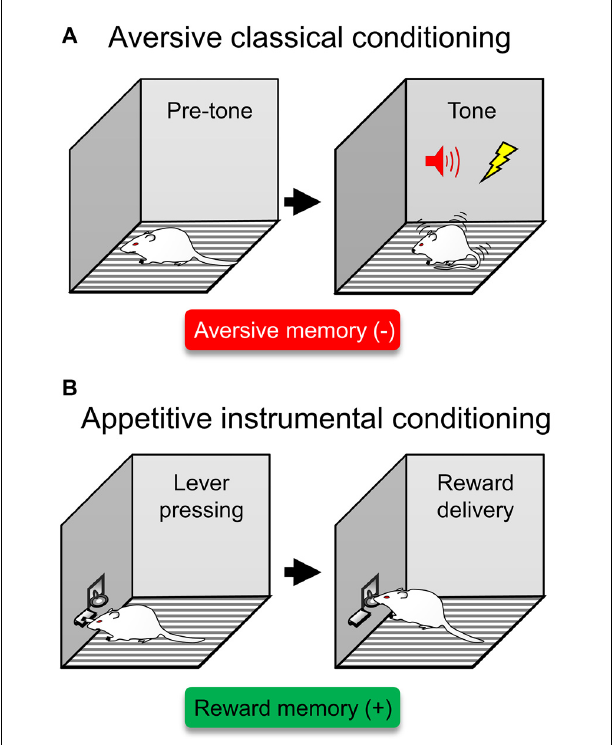
FIGURE 1 | Traditional behavioral assays to probe isolated aversive or reward memories. (A) A type of aversive classical conditioning is auditory threat (fear) conditioning. In this type of aversive learning, rodents are presented with a tone that predicts a foot-shock. After several exposures of this tone/shock pairings, rodents express defensive responses in the form of conditioned freezing. This behavioral assay has been traditionally used to probe aversive memories (red box), representing a previous experience that acquired a negative valence ( − ). (B) In appetitive instrumental conditioning, rodents learn to press a lever to obtain reward, often in the form of food. This behavioral assay has been traditionally used to probe reward memories (green box), representing a previous experience that acquired a positive valence